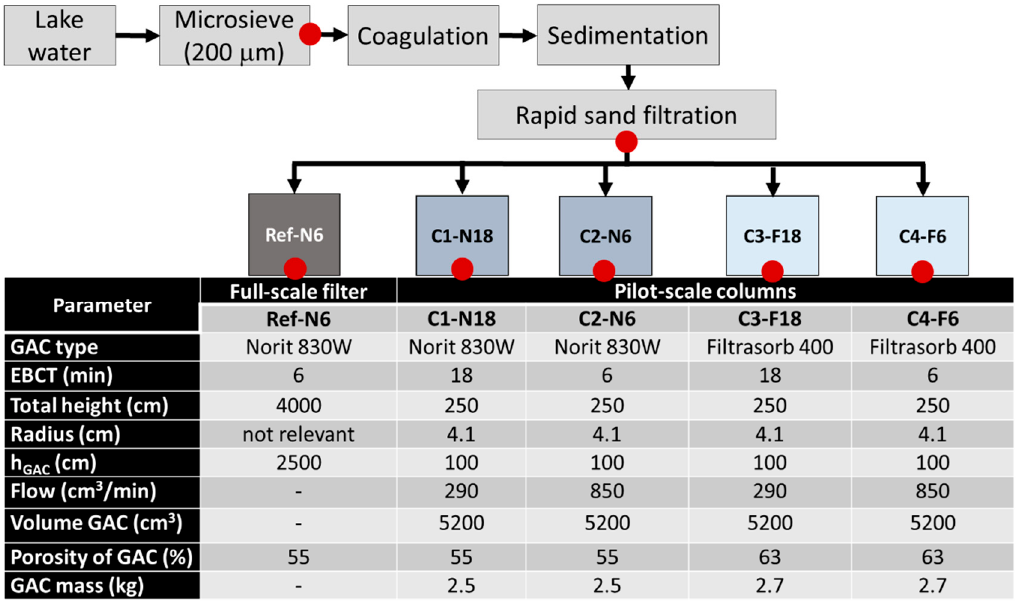
Figure 1. Schematic diagram of treatment in the full-scale granulated activated carbon (GAC) filter (type Norit 830W) and pilot-scale GAC columns (Norit 830W and Filtrasorb 400), and parameters used in treatment. EBCT = empty bed contact time; h GAC = height of the GAC in the filter and columns (cm); red dots represent sampling locations for OMPs.